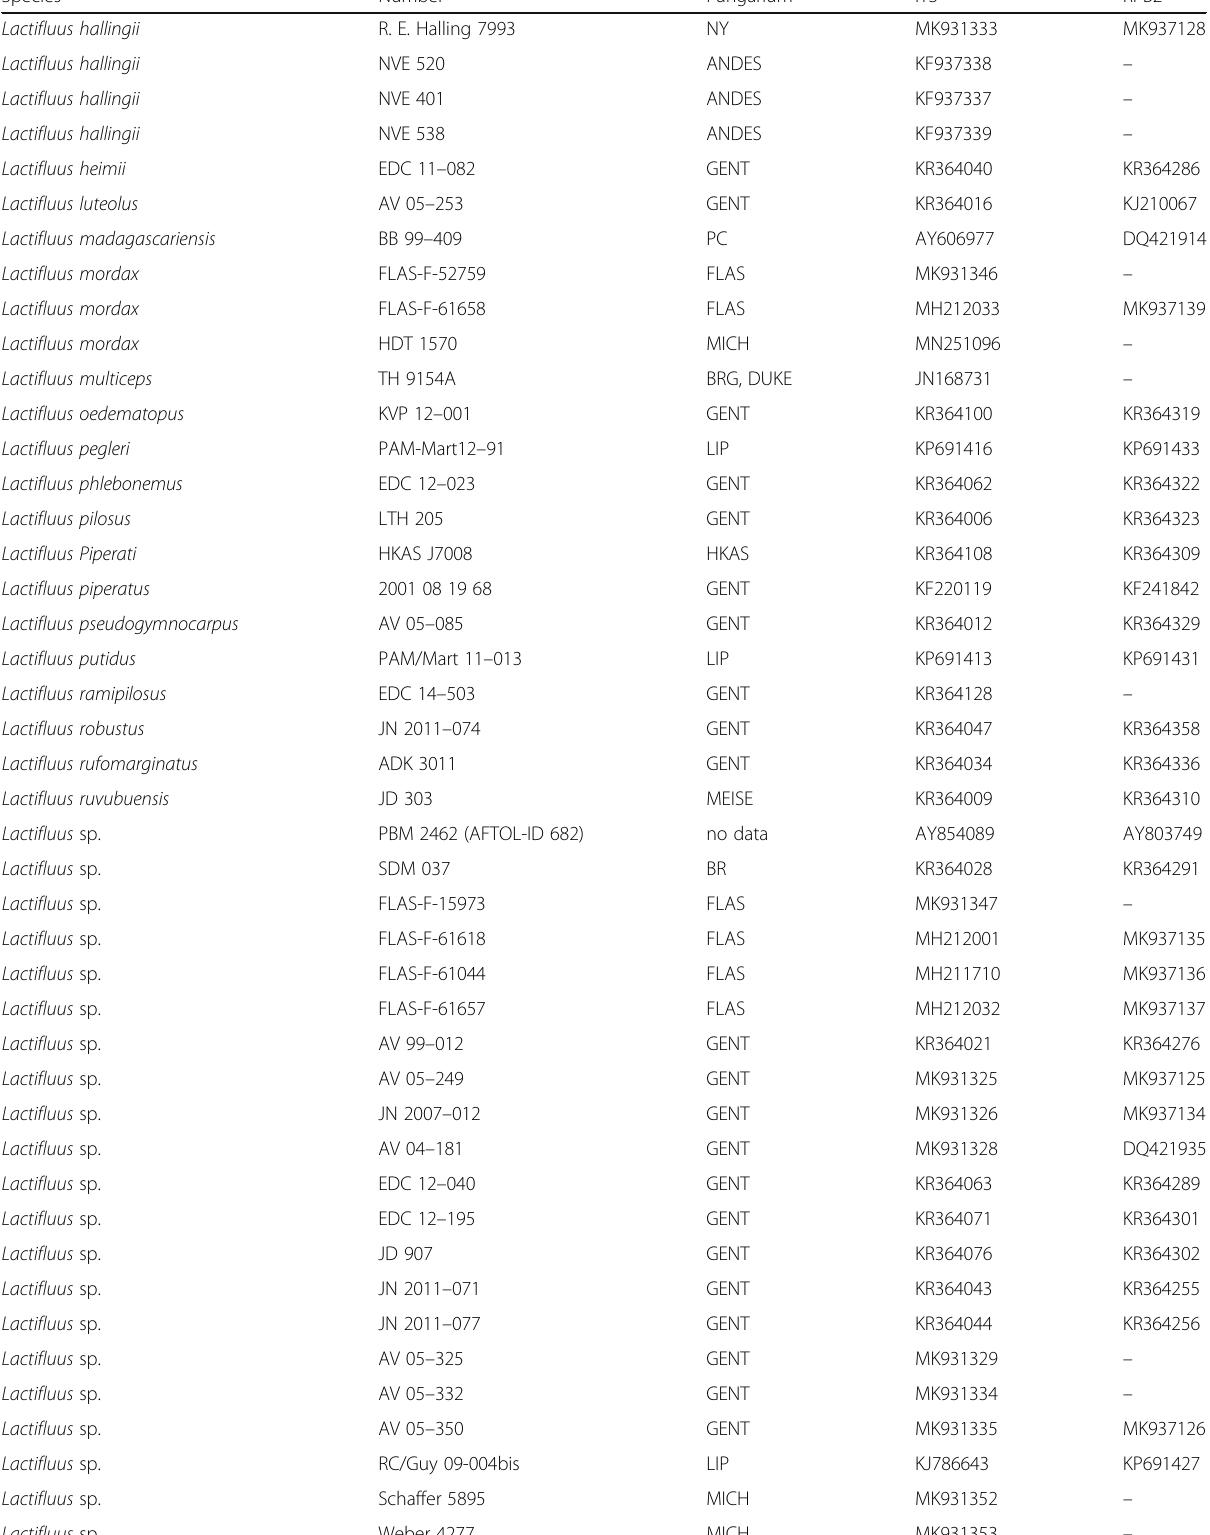
Table 1 Specimens and GenBank accession numbers of DNA sequences used in the molecular analyses (Continued)